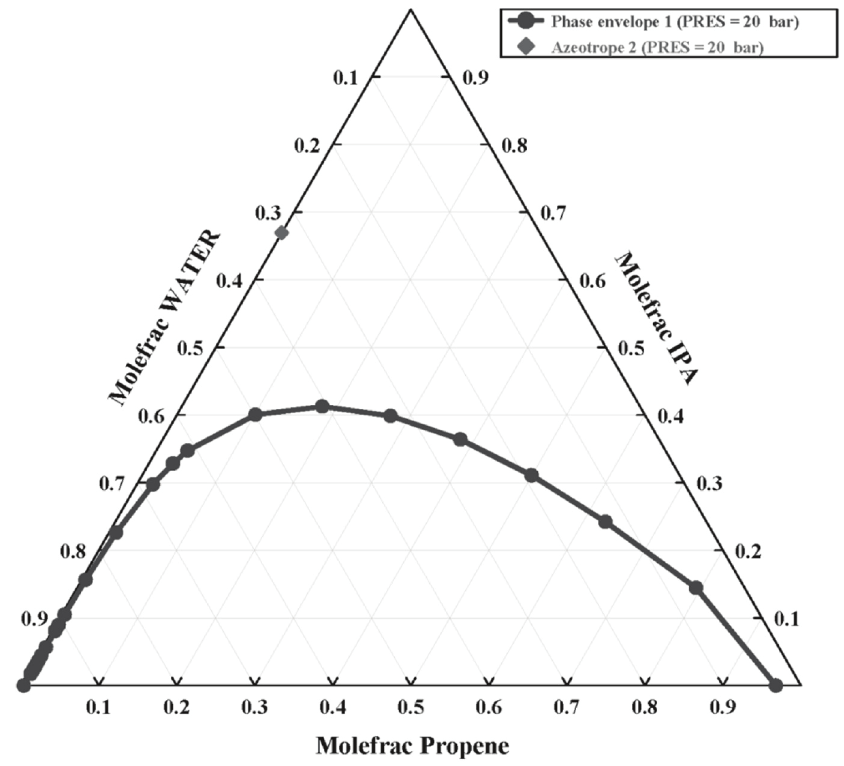
Fig. 3 – Triangular diagram for the ternary system of propylene/IPA/Water at pressure of 20 bar